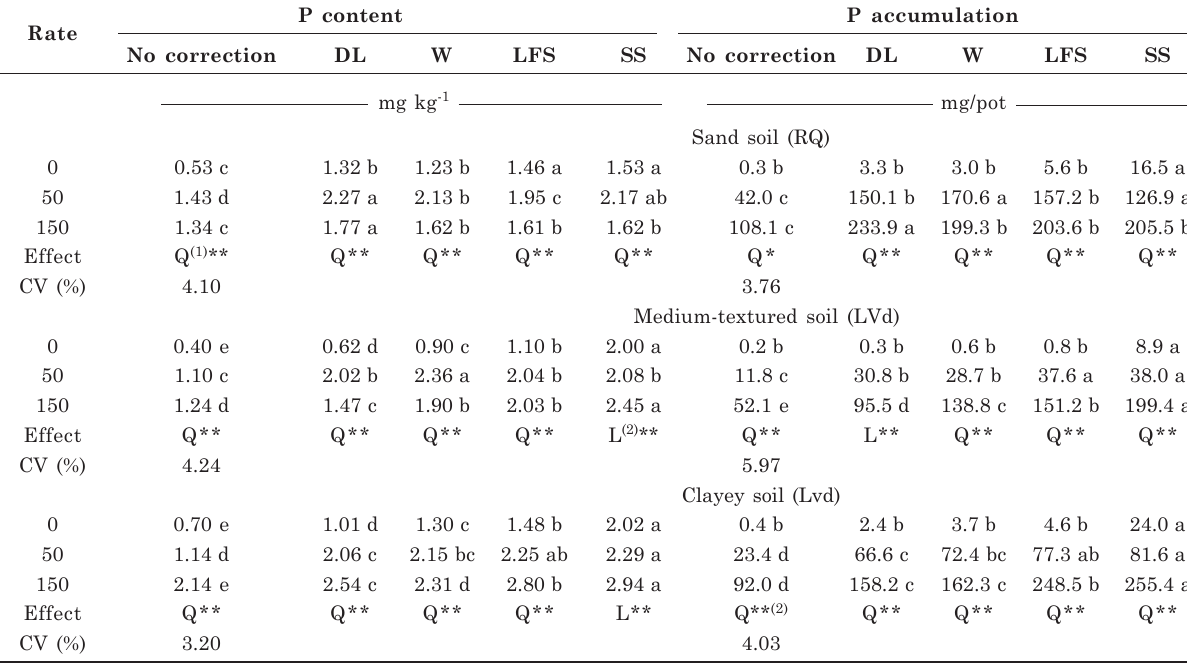
Table 5. Phosphorus content and P accumulation in corn plants after application of correctives (dolomitic lime - DL, ladle furnace slag - LFS, wollastonite - W, steelmaking slag - SS) and P rates